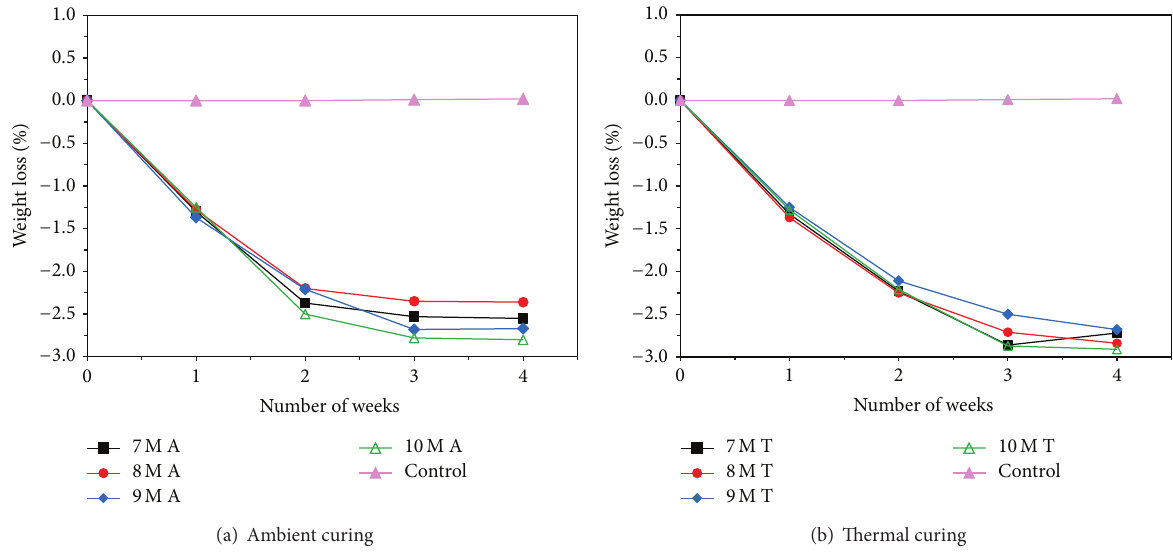
Figure 10: Weight loss for specimens immersed in 5% Na 2 SO 4 after 28 days.